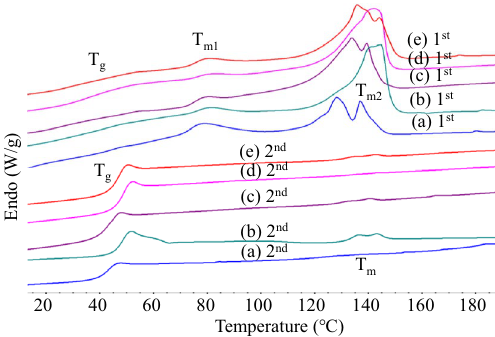
Figure 7. DSC thermograms from the 1st and 2nd heating cycles of alcohol-acidolyzed PLA: ( a ) LD6M, ( b ) LD12M, ( c ) LD12B0.2 M, ( d ) LD16M, ( e ) LD16B0.2 M.